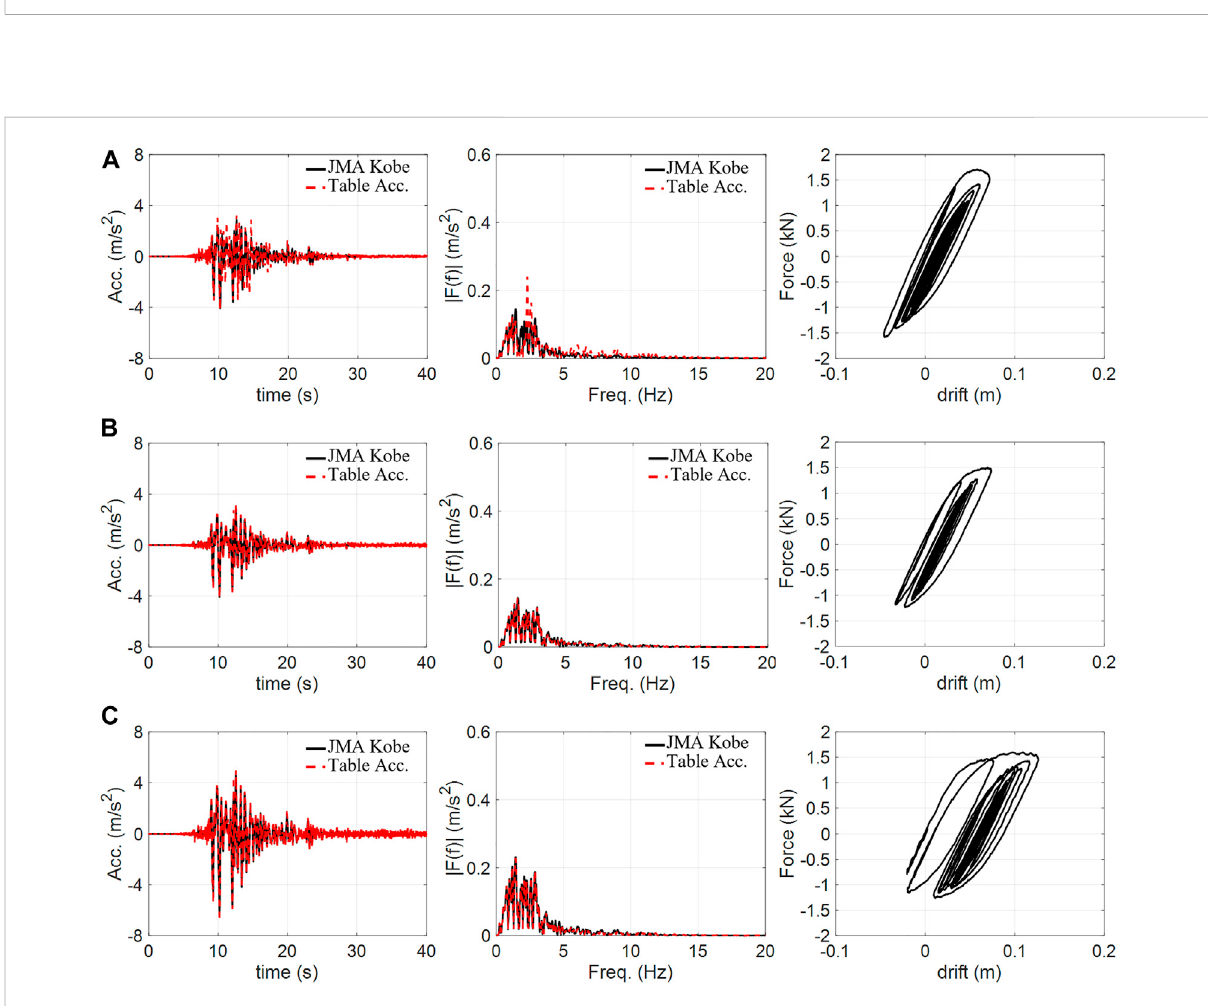
FIGURE 12 Shake table experiments with a steel structure: (A) IBC for 50% JMA Kobe motion, (B) NSBC for 50% JMA Kobe motion and (C) NSBC for 80% JMA Kobe motion. (left: time-history table acceleration, middle: Fourier amplitude spectra of table acceleration, right: structural